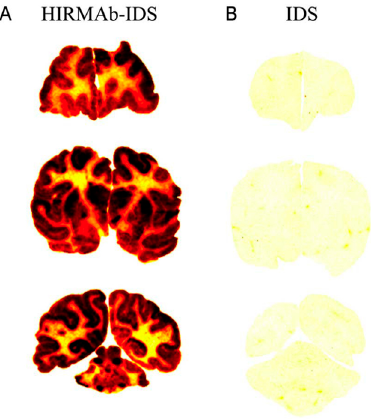
Figure 5. Film autoradiogram (20 µm sections) of rhesus monkey brain removed 2 h after IV injection of the HIRMAb-IDS fusion protein ( A ) or IDS ( B ). Scans were produced after labeling of the HIRMAb-IDS fusion protein or IDS with [ 125 I]-Bolton–Hunter reagent. The forebrain section is on the top, the midbrain section is in the middle, and the hindbrain section with cerebellum is on the bottom. From reference [68] with permission.